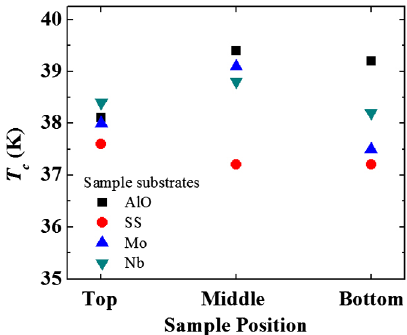
FIG. 7 (color online). Critical temperatures for different sub- strates at different locations in the stainless steel